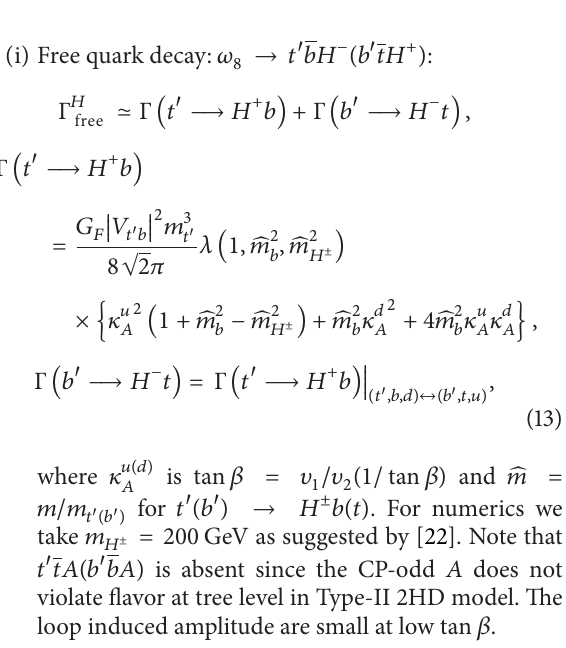
for given parameter sets in Cases 1 to 8